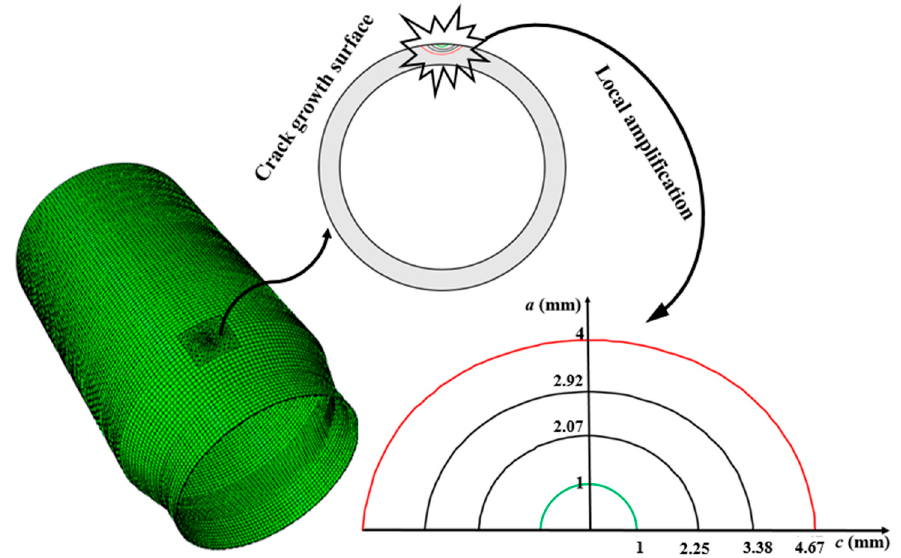
Figure 12. Change of crack surface during crack propagation.